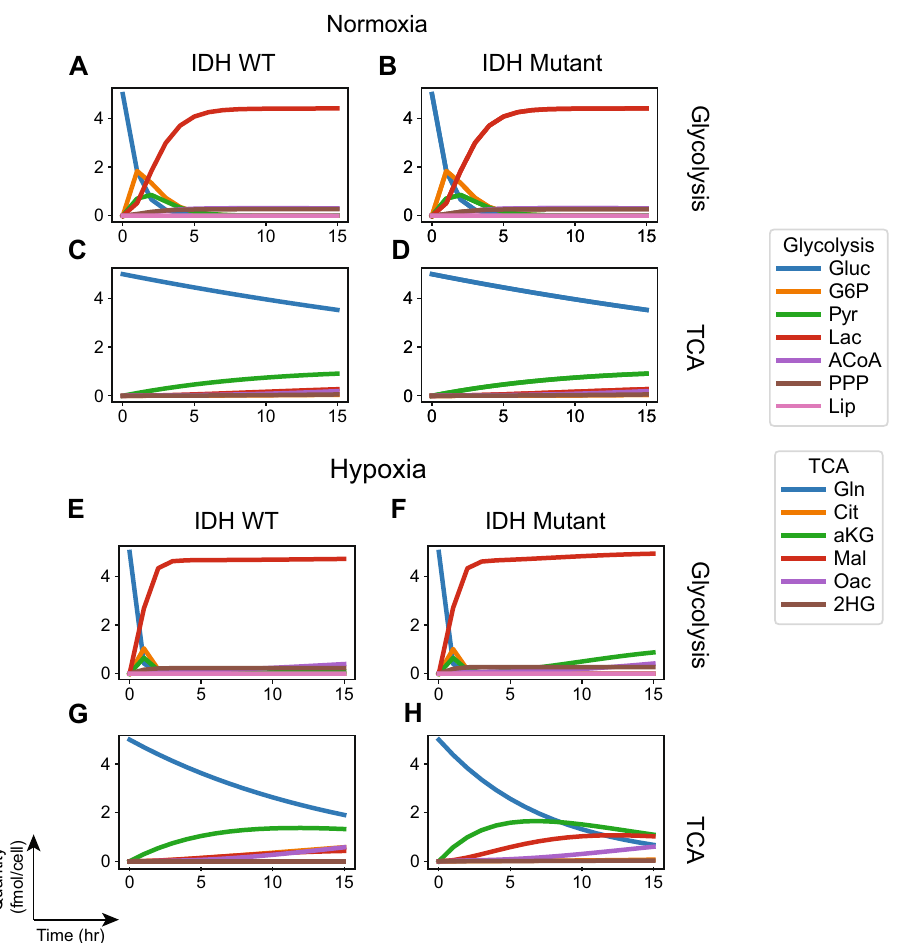
Figure 2. Metabolic phenotypes based on flux rates measured on isogenic cell lines. ( A – H ) Rates from Grassian et al. 14 were used to instantiate the models of behavior under normoxia ( A – D ) and hypoxia ( E – H ). The model checking problem was expressed as characterizing the transient quantity of molecular species at a given instant in time. Glucose and glutamine are initiated at maximum quantity 5 (fmol/cell) and all other species at